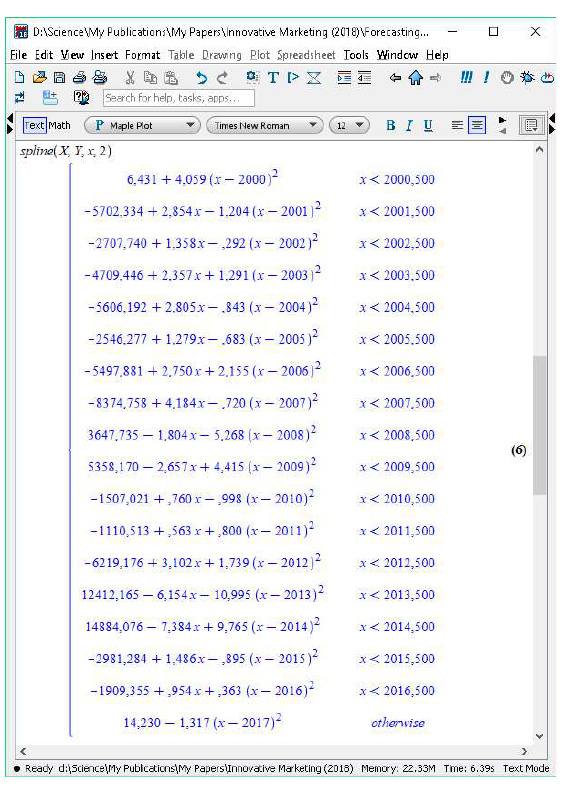
Figure A3. Function description of quadratic spline